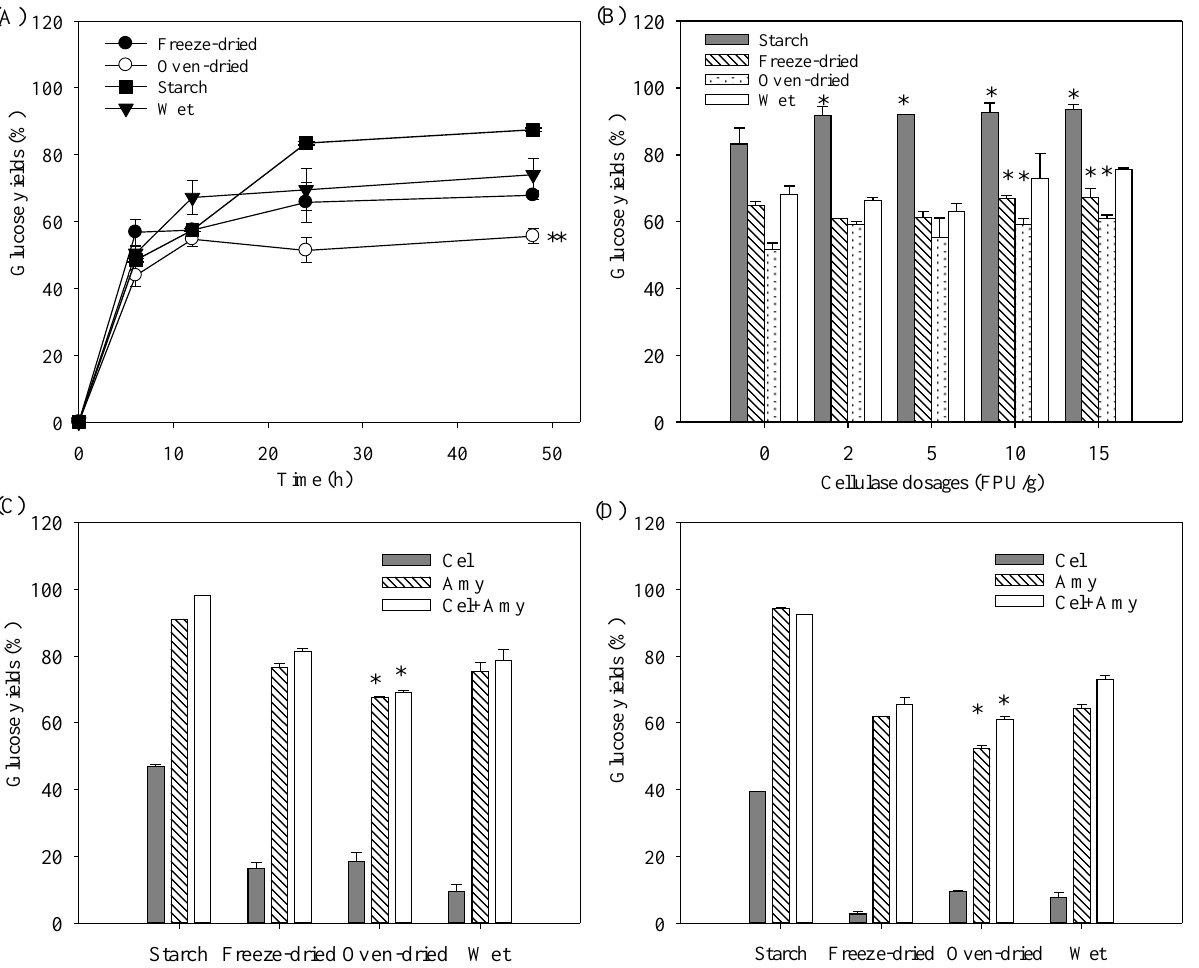
Figure 3. Enzymatic hydrolysis of pure starch, freeze-dried, oven-dried, and wet microalgal biomasses: ( A ) with the amy enzyme mixture ( α -amylase and amyloglucosidase); the * indicates the significant differences ( p < 0.05) of the oven-dried sample compared to the freeze-dried and wet samples; ( B ) with the addition of different dosages of cellulase in the amy enzyme mixture; the * indicates the significant differences ( p < 0.05) of the samples hydrolyzed with cellulase compared to those without cellulase; ( C ) with Na–citrate buffer system; Cel, cellulase; amy, α -amylase, and amyloglucosidase mixture; Cel and amy, mixture of cellulase and amy; the * indicates the signifi- cant differences ( p < 0.05) of the oven-dried sample compared to the freeze-dried and wet samples; ( D ) with water system; Cel, cellulase; amy, α -amylase, and amyloglucosidase mixture; Cel+Amy, mixture of cellulase and amy; the * indicates the significant differences ( p < 0.05) of the oven-dried sample compared to the freeze-dried and wet